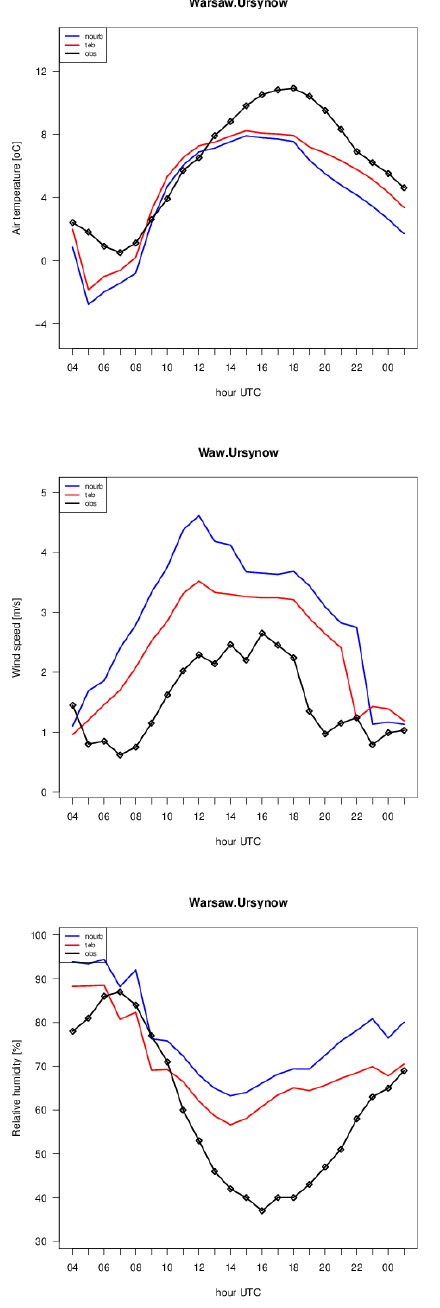
Figure 14 Comparison of modelled meteorological parameters with observations from Fig. 14. Comparison of modelled meteorological parameters with observations from Warsaw-Ursynow station for 29 March 2011 (red Warsaw-Ursynow station for 29 th of March 2011 (red line – urban scenario, blue line = line - urban scenario, blue line - non-urban scenario, black line - observations). non-urban scenario, black - observations)